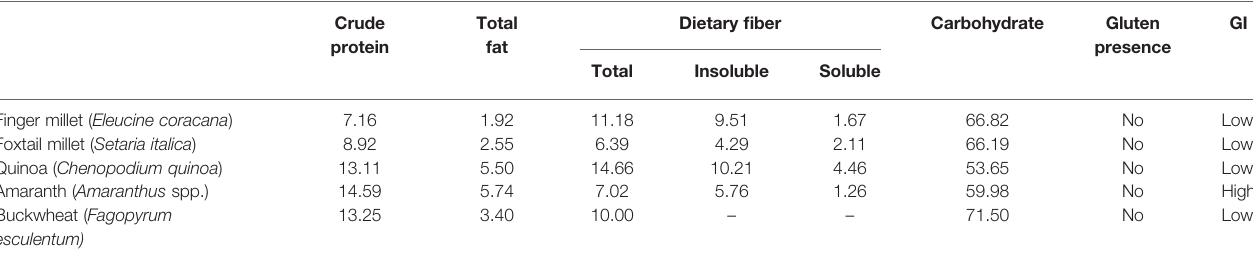
TABLE 1 | Proximate component pro fi le of grains.